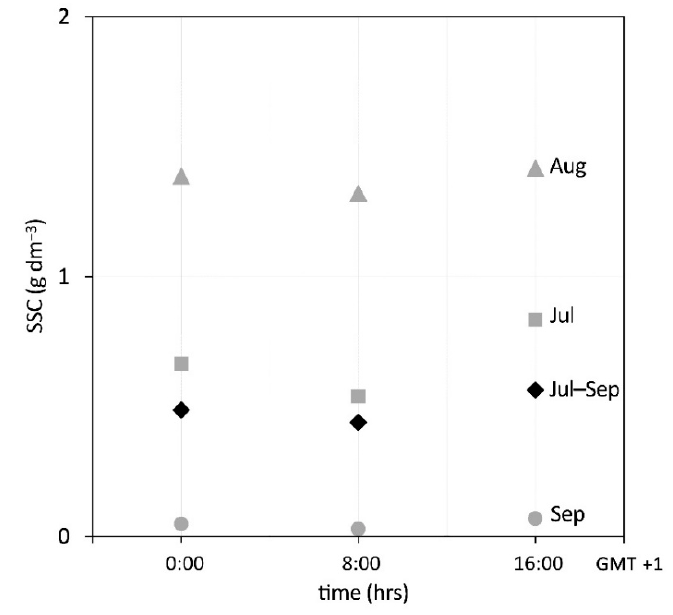
Figure 2. Daily changes of suspended sediment concentration at the Breelva River in 2007, based upon monthly averaged sampling every 8 h (for July n = 29 days, August n = 31 days, September n = 7 days).